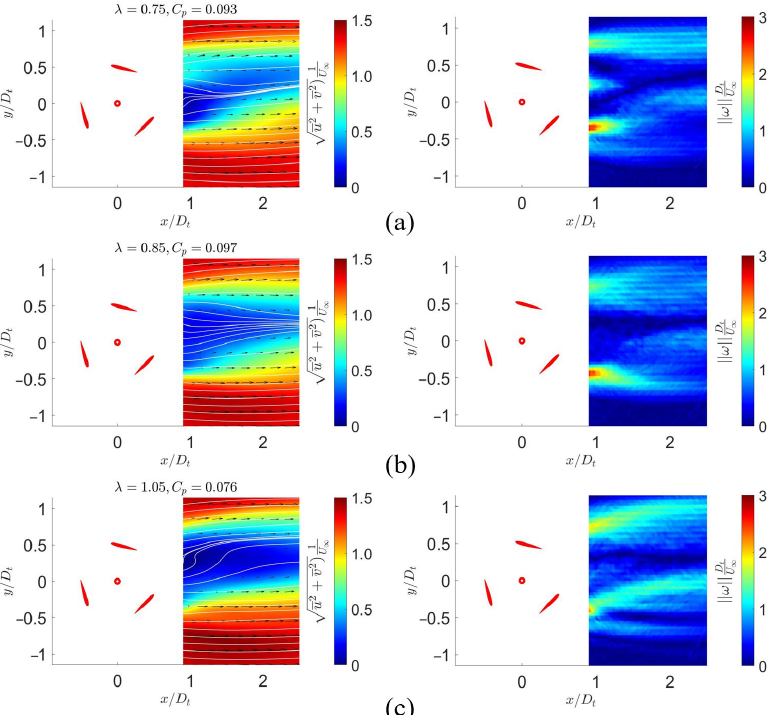
Figure 11. The time-averaged non-dimensionalized velocity and vorticity of the T1 configuration at λ = 0.75 ( a ), λ = 0.85 ( b ), and λ = 1.05 ( c ) with the associated power coefficients. The red circle displays turbine T1 rotation center.